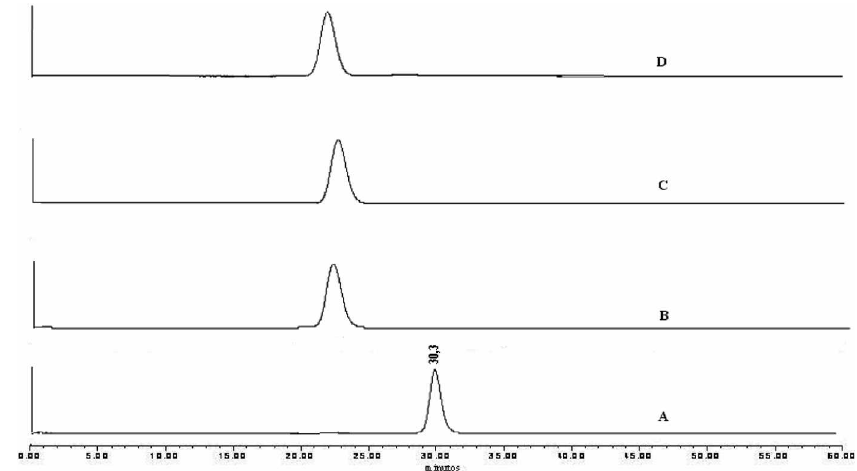
Figure 3 - SE HPLC chromatogram of conjugation of Streptavidin with Biotin-PEG-BBN. (A) B- PEG-BBN; (B) SA:B-PEG-BBN (1:1); (C) SA:B- PEG-BBN (1:2); (D) SA: B-PEG-BBN (1:3).